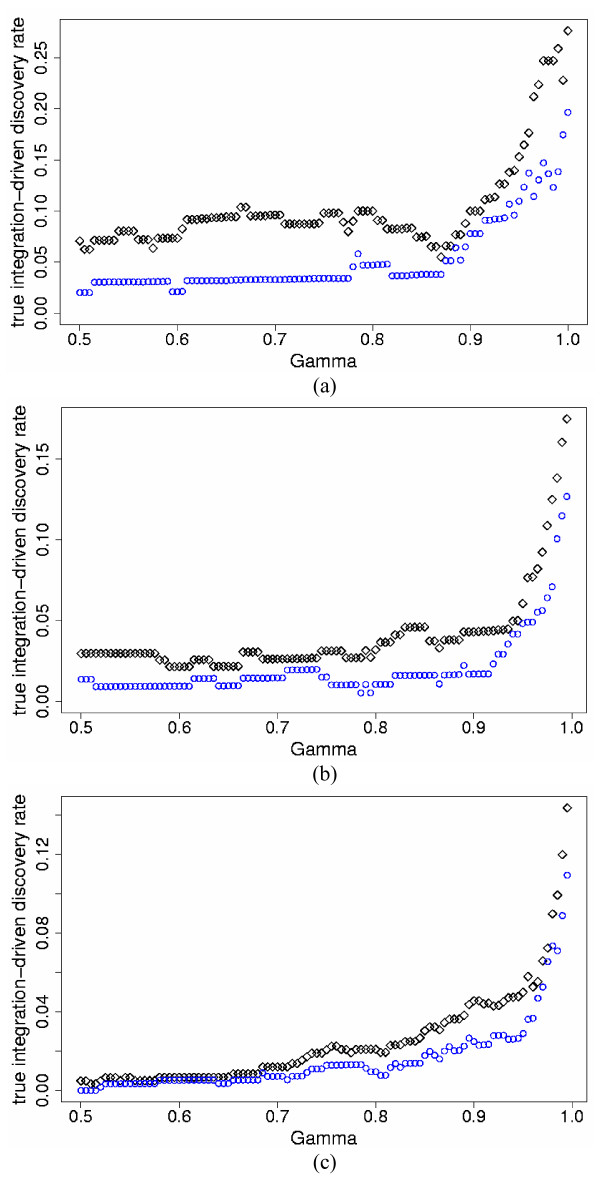
tIDR versus posterior probability of differential expression for the two-study simulation data. True integration-driven discovery rate (tIDR) versus threshold values of posterior probability of differential expression γ ≥ 0.50, for the standardized expression integration model (blue circles) and probability integration model (black diamonds) for the two-study simulation data with high mean τg2
 MathType@MTEF@5@5@+=feaafiart1ev1aaatCvAUfKttLearuWrP9MDH5MBPbIqV92AaeXatLxBI9gBaebbnrfifHhDYfgasaacH8akY=wiFfYdH8Gipec8Eeeu0xXdbba9frFj0=OqFfea0dXdd9vqai=hGuQ8kuc9pgc9s8qqaq=dirpe0xb9q8qiLsFr0=vr0=vr0dc8meaabaqaciaacaGaaeqabaqabeGadaaakeaaiiGacqWFepaDdaqhaaWcbaGaem4zaCgabaGaeGOmaidaaaaa@30EE@ = 0.7 (differentially expressed); 0.07 (non-differentially expressed) and the following simulated percent differentially expressed genes ps: a) 5%; b) 10%; c) 25%.